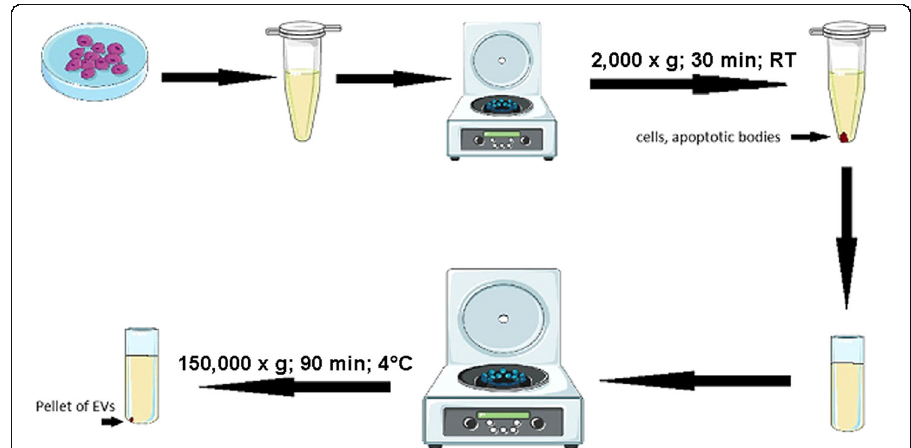
Fig. 1 The workflow for EV isolation. Adapted from